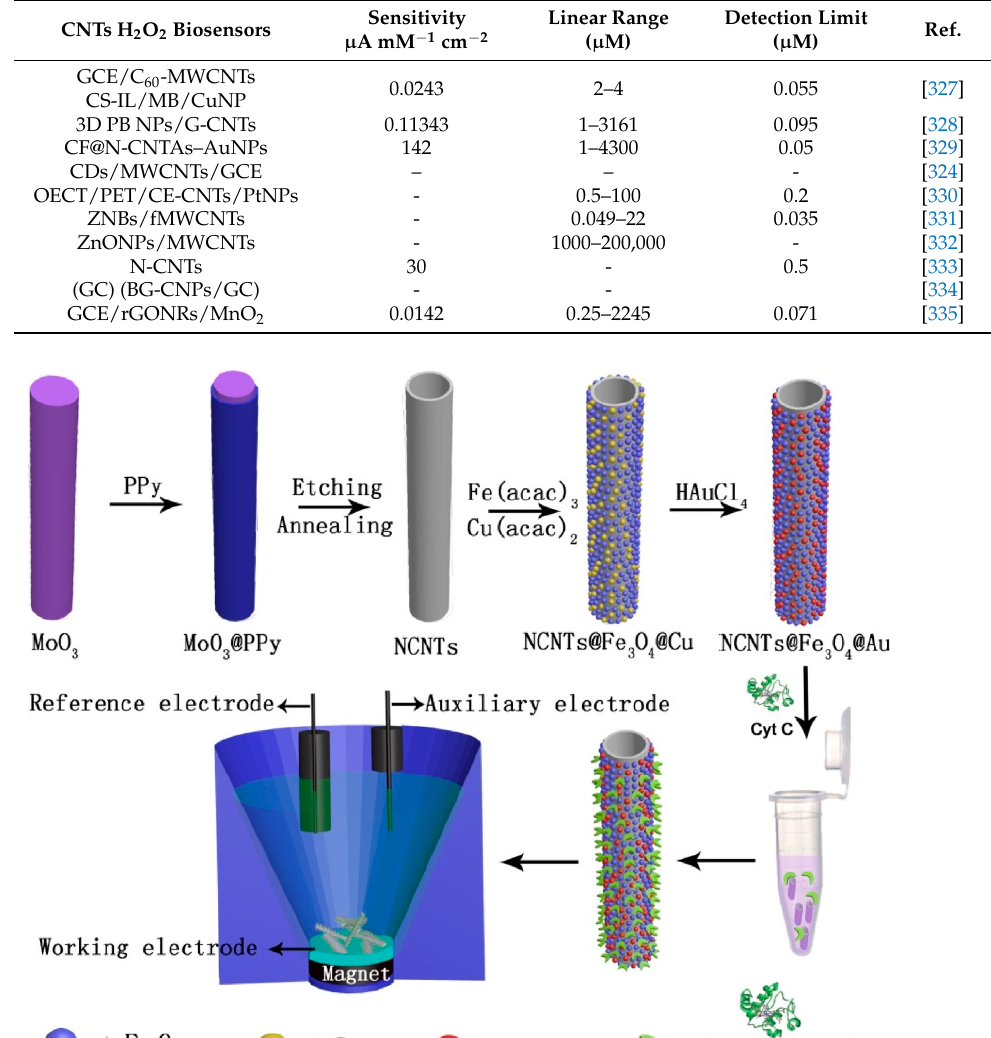
Figure 7. Mechanism of metal nanoparticle loaded CNTs for real-time analyses of H 2 O 2 secreted from live cells. Reproduced with permission from [324], Copyright 2016 Spinger Ltd (Berlin/Heidel- berg, Germany).